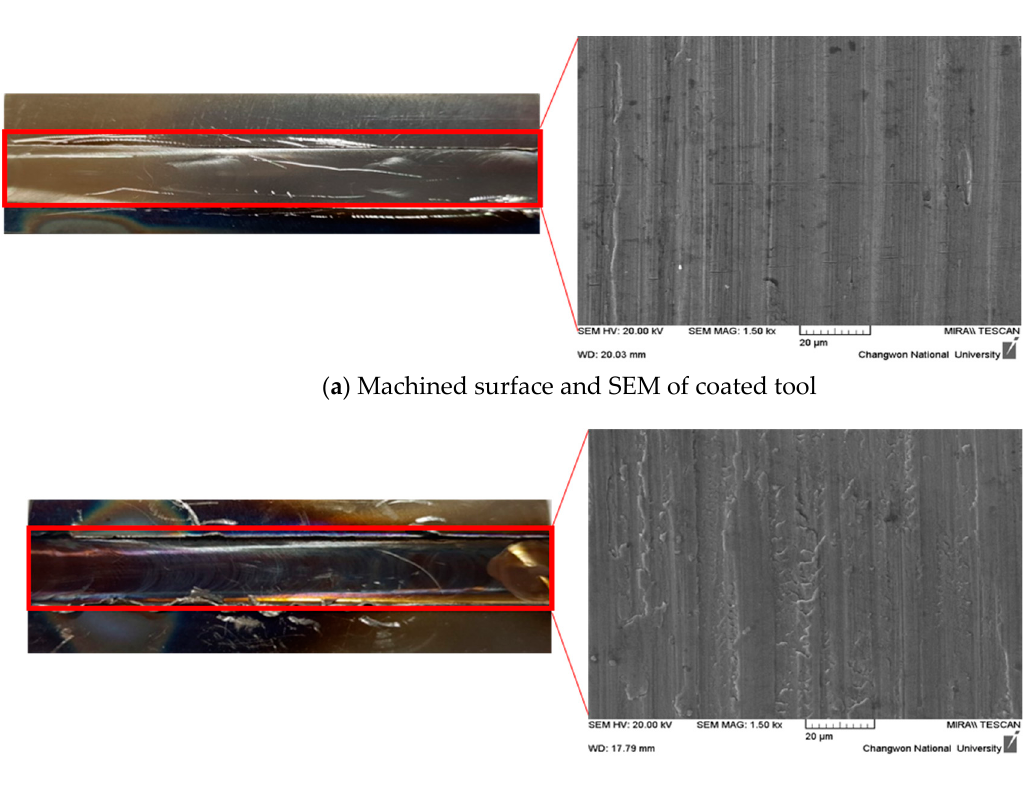
Table 11. The response optimization.